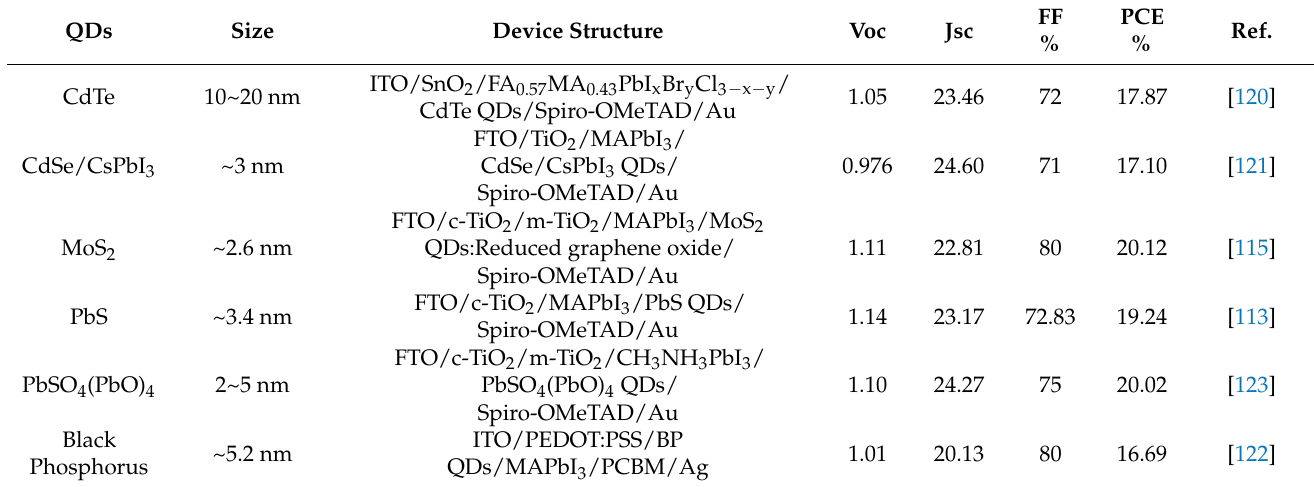
Figure 8. ( a ) Schematic illustration of the ligand exchange process of CdTe QDs. Reproduced from [120], with permission from Elsevier, 2018. ( b ) Schematic diagram of the energy transfer (ET) and charge transfer in the device. Reproduced from [121], with permission from Royal Society of Chemistry, 2020. ( c ) Schematic and energy diagrams of PbSO 4 (PbO) 4 -QD-based devices. Reproduced from [123], with permission from Elsevier, 2019. ( d ) Schematic of CH 3 NH 3 PbI 3 /PbSO 4 (PbO) 4 QDs’ interfacial passivation. Reproduced from [123], with permission from Elsevier, 2019. Table 6. Details of other QDs as the perovskite/HTL interface